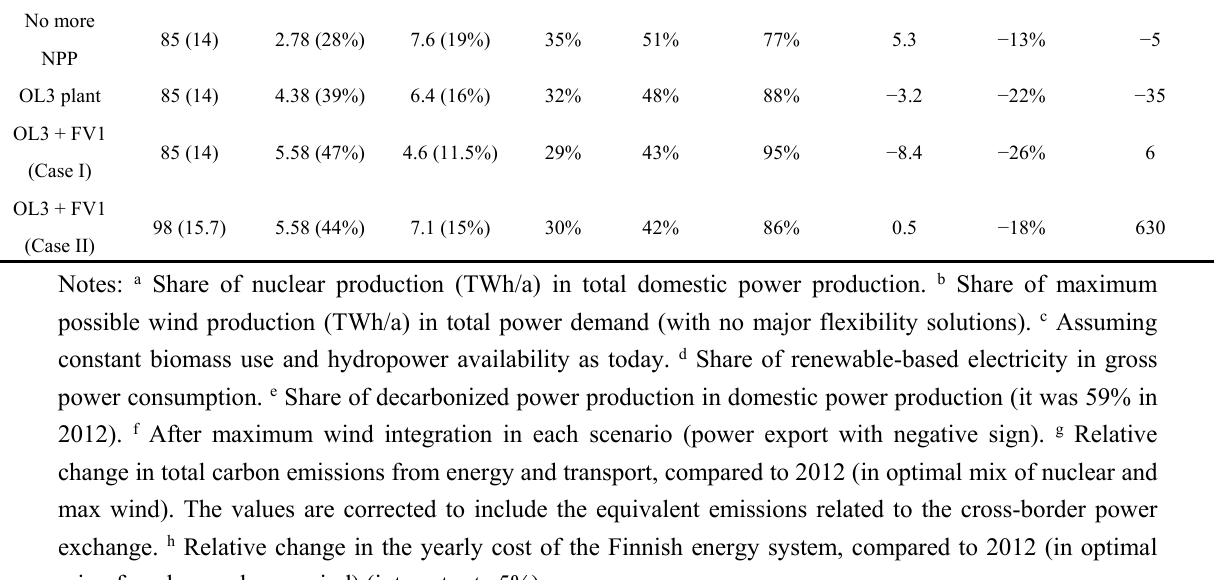
Different Scenarios